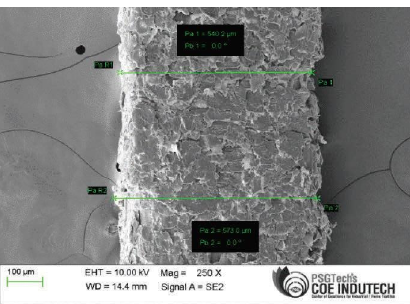
Figure 7: SEM images of untreated fber.